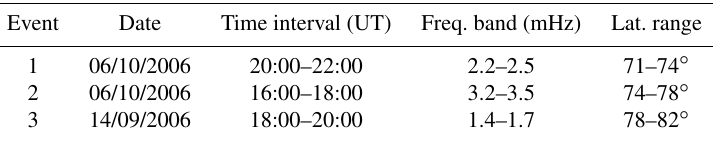
Table 1. Events used in study. The latitude range is the nominal target range for Northern Hemisphere events, which were seen in ground scatter. Their pulsation location is at a lower latitude.